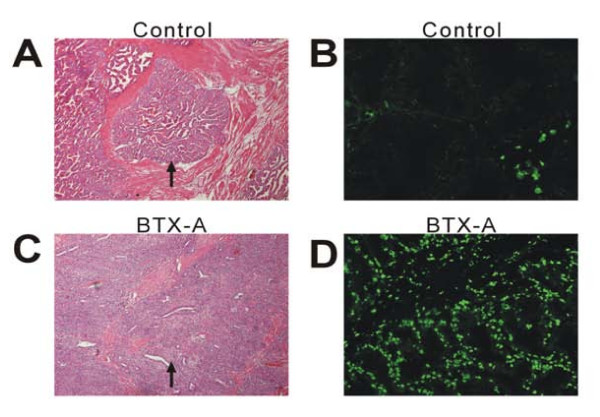
Photomicrographs and terminal deoxynucleotidyl-mediated deoxyuridine triphosphate nick end labeling (TUNEL) staining of prostate sections after saline (A,B) and BTX-A (C,D) injection at 1 month. Significant glandular proliferation with papillary infolding in the lumen was seen in the control canine (A). Atrophy change of glandular component with flattening of the lining epithelium was seen in the BTX-A treated canine (C). Very few apoptotic nuclei are recognizable in the control animal (B). Strong fluorescence of apoptotic nuclei was seen in the BTX-A treated animal at 1 month. A, C magnification × 40; B, D magnification × 100.